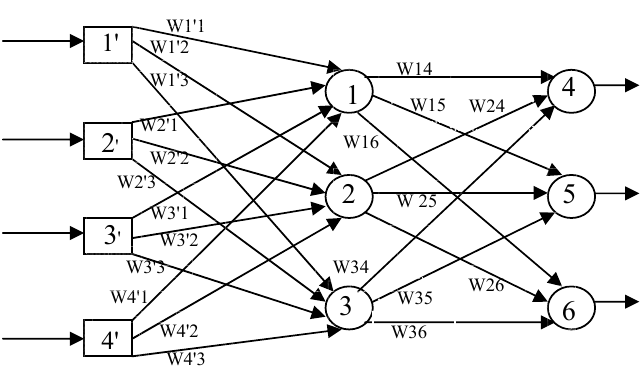
Fig 1: The Neural Network for the Iris Data Classification A neural network stores the knowledge in the form of weights [10]. The weights are to be properly adjusted so that the Iris plants are classified properly. The activation function used for the neural network is the sigmoid function. The sigmoid function can functionally be represented as Sigmoid(x) =1/ (1+e -x ) 4. Neural Back Propagation The back propagation is one of the most common algorithms to train a neural network [11], [12]. The back propagation algorithm for the Iris data problem uses the